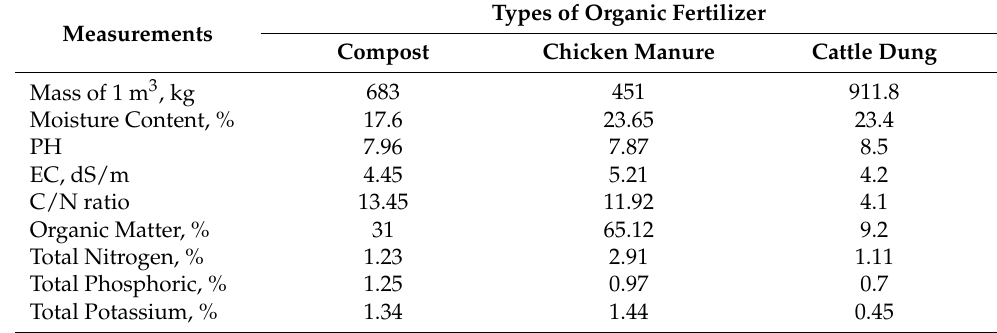
Table 3. Characteristics of the used organic fertilizers.